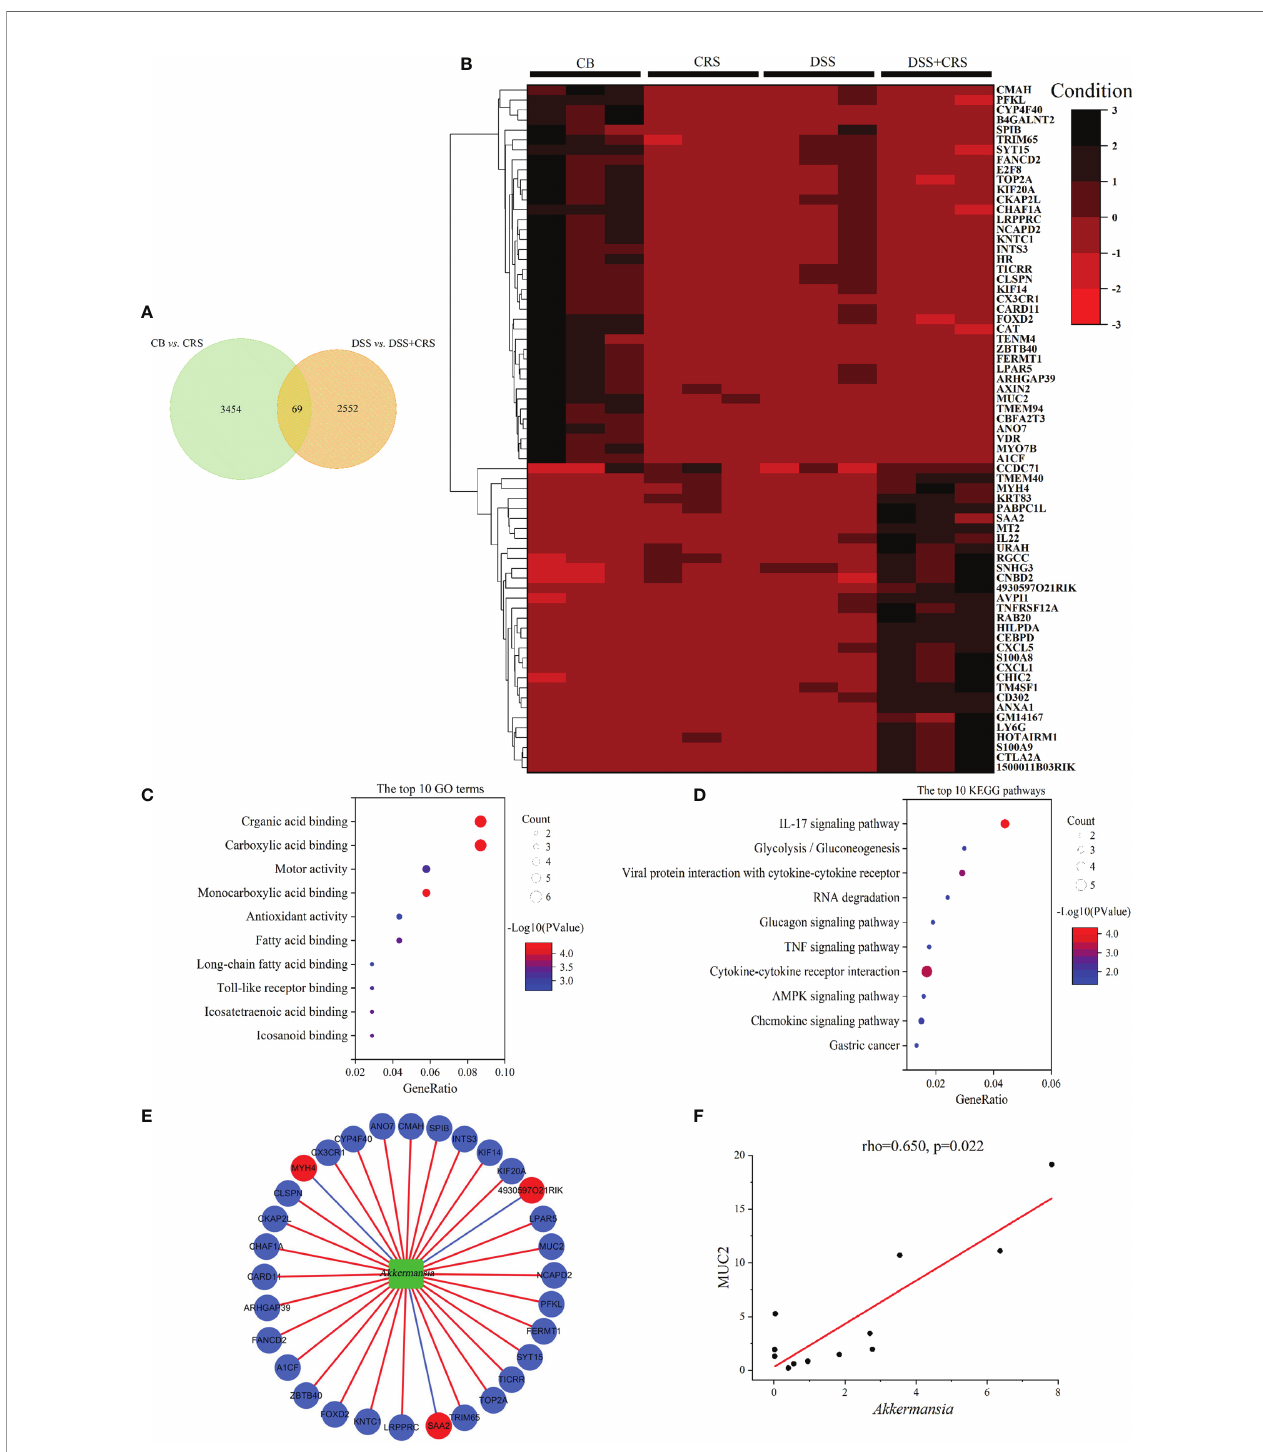
FIGURE 5 | DEGs under CRS were analyzed by high-throughput RNA-Seq. (A) Venn diagram showing 69 DEGs changed under CRS from the two comparisons. (B) Heat-map presented 69 DEG in the two comparisons (n = 3). (C) The 10 most disordered GO terms were identi fi ed from the 69 DEG in the two comparisons. (D) The top 10 KEGG pathways were identi fi ed from the 69 DEG in the two comparisons; (E) Network visualized the correlations between A. muciniphila and genes. Green node represented A muciniphila . Red and Blue nodes represented the raising and lowering of DEGs. Blue lines represented negative correlation, and red lines represented positive correlation; (F) Scatterplot showing that MUC2 was positively correlated with A. muciniphila